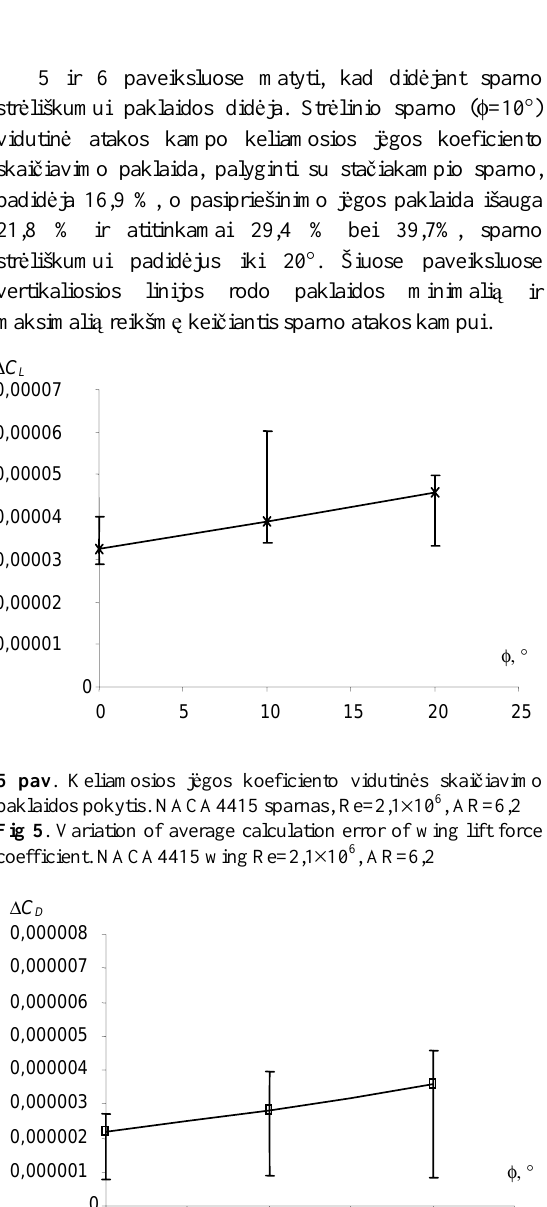
6 pav . Pasipriešinimo j ė gos koeficiento vidutin ė s skai č iavimo Fig 6 . Variation of average calculation error of wing drag force coefficient. NACA4415 wing Re=2,1 × 10 6 , AR=6,2 4. Išvados